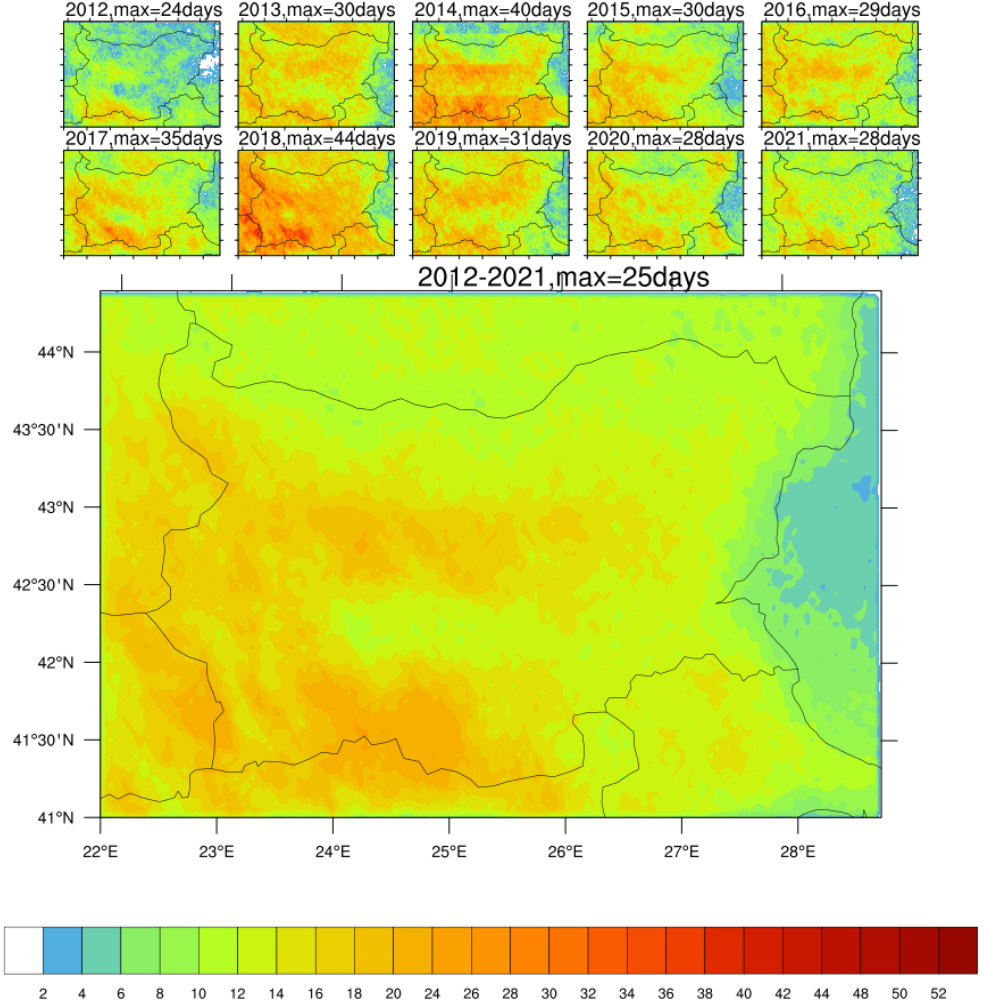
Figure 10. Annual spatial (on a grid of 0.05 × 0.05 deg) distribution of days with flashes (number